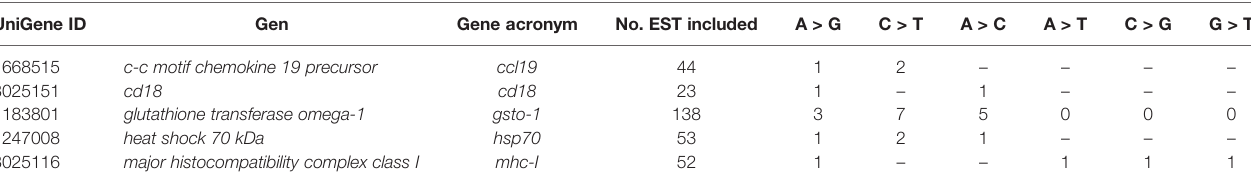
TABLE 1 | Summary of single-nucleotide polymorphisms (SNPs) identi fi ed in a set of immune-related genes expressed in Salmo salar . UniGene